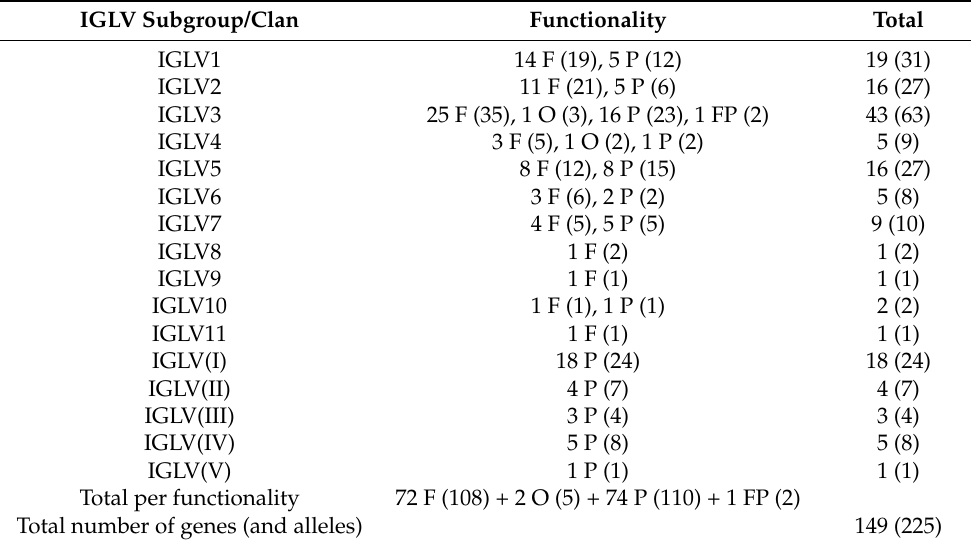
Table 8. For each IGLV subgroup, number of IGLV genes per functionality and, between parentheses, number of alleles is